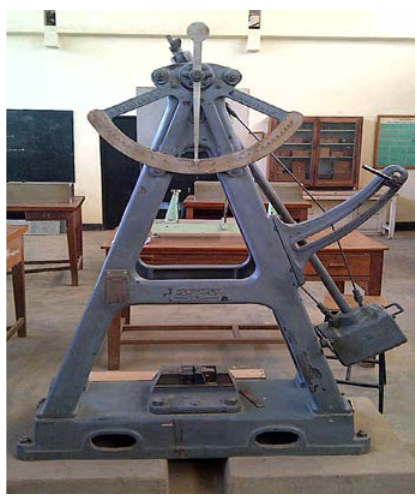
Figure 6: Izod Impact Machine